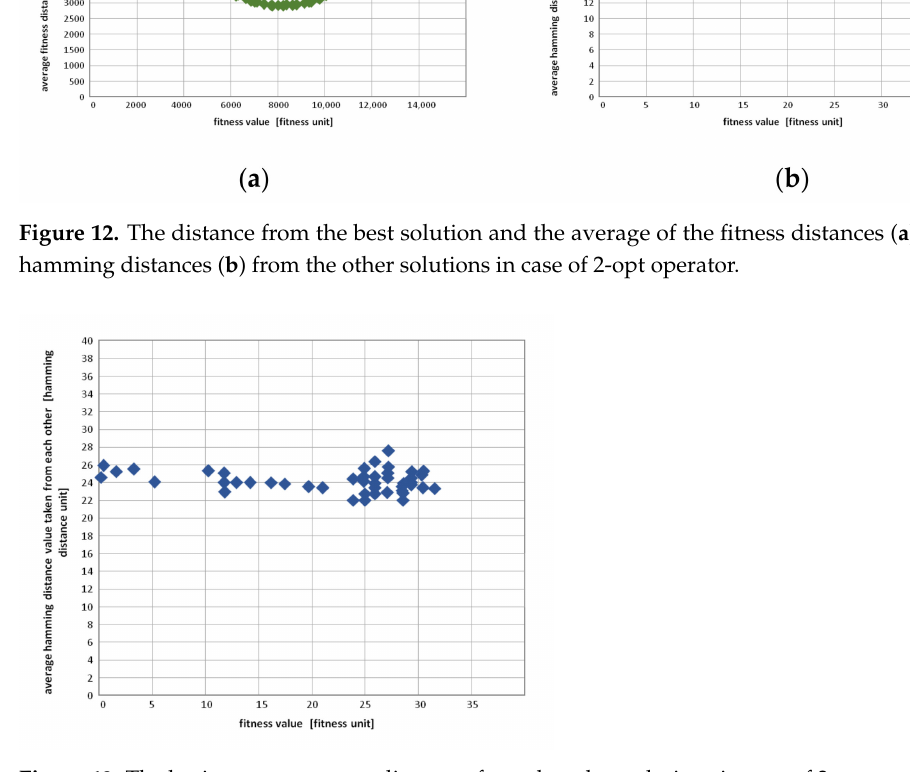
Figure 13. The basic swap sequence distances from the other solutions in case of 2-opt operator.